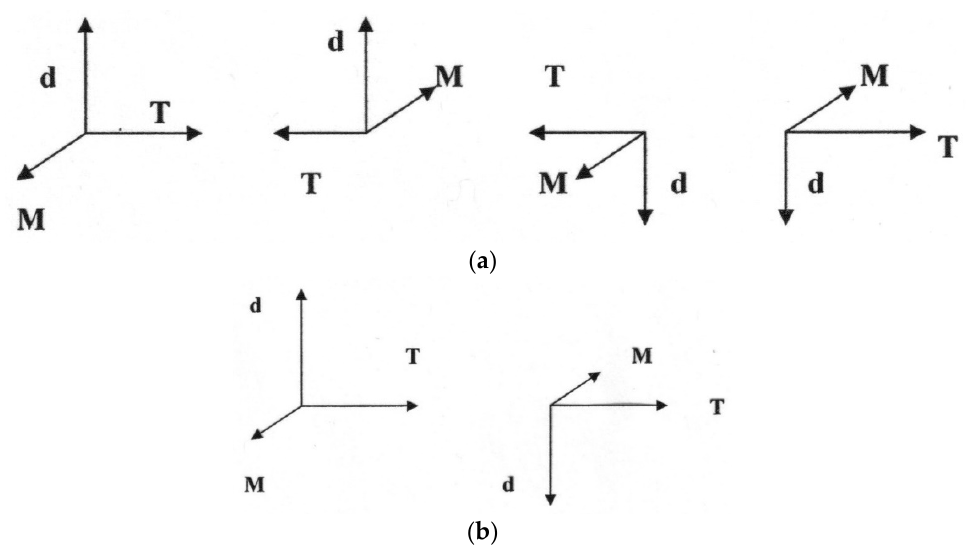
Figure 4. ( a ) Antiferrotoroidal ordering in a four sublatice crystal; ( b ) Ferrotoroidal ordering in a two sublattice crystal.